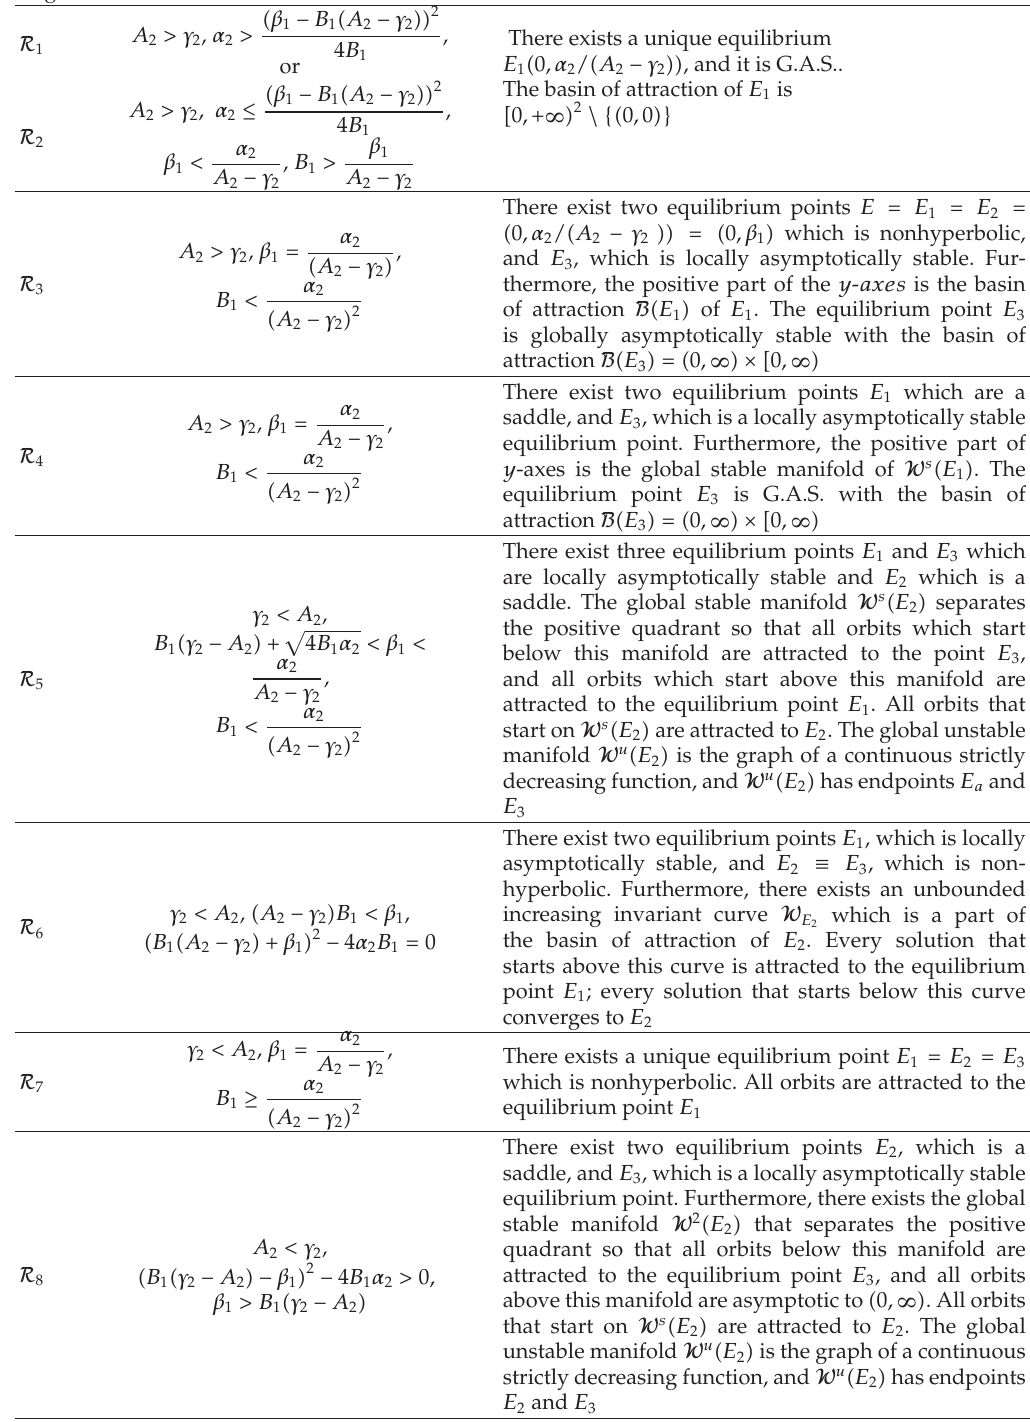
Table 2: Global behavior of system (cid:5) 1.1 (cid:6) . GAS stands for globally asymptotically stable. Region R